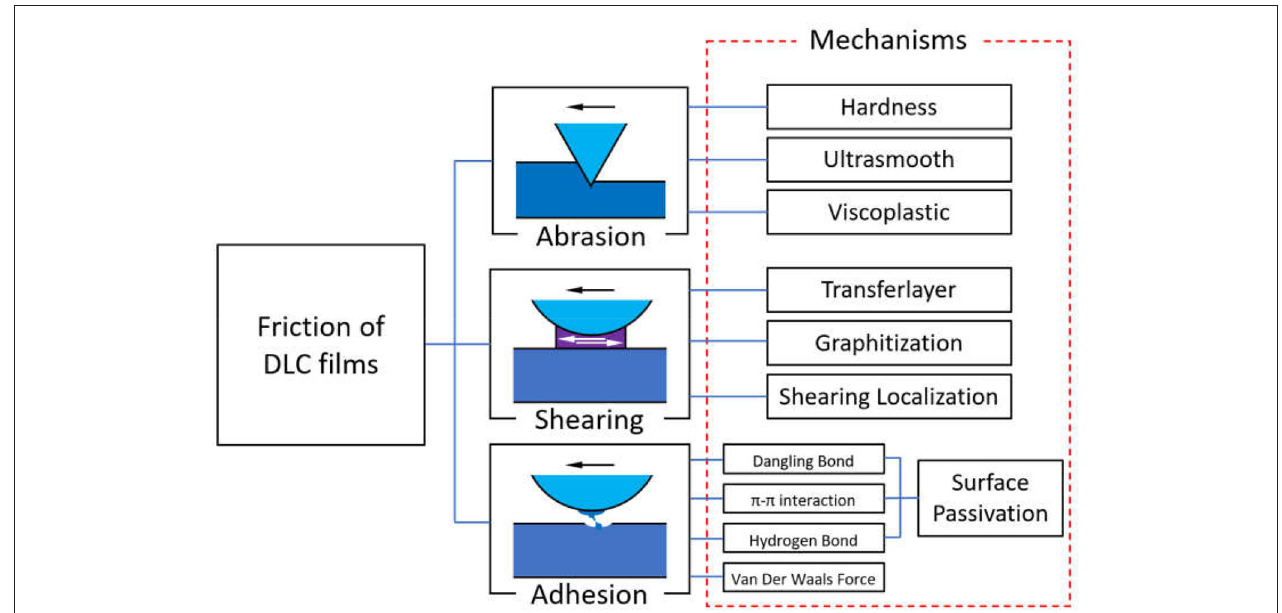
FIGURE 10 | The origins of friction for DLC films and mechanisms for their elimination.